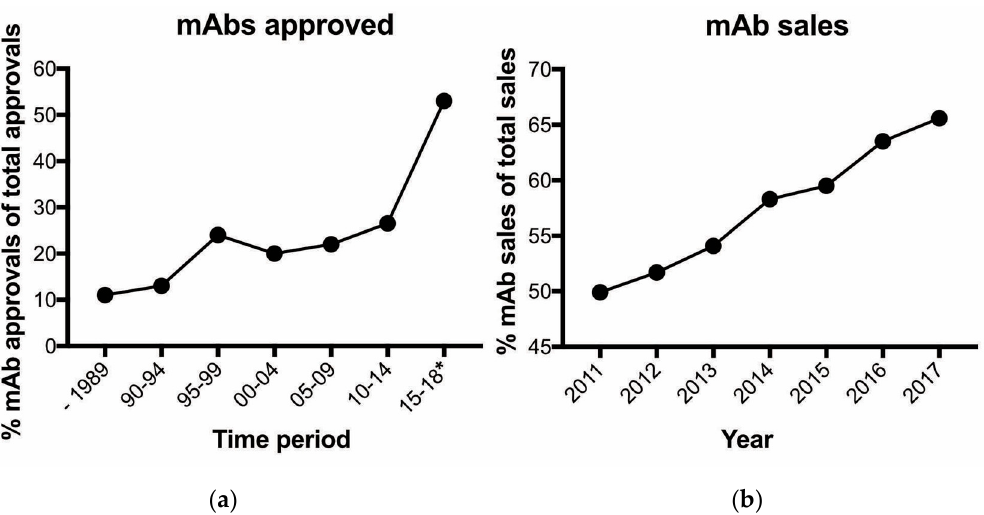
Figure 1. Overview of antibody impact in the biopharmaceutical market. ( a ) The percentage of first-time mAb approvals of total biopharmaceuticals during the indicated time periods. ( b ) The percentage of global mAb sales of total biopharmaceuticals for indicated years. Data obtained and adapted from reference [5]. * Until July 2018.